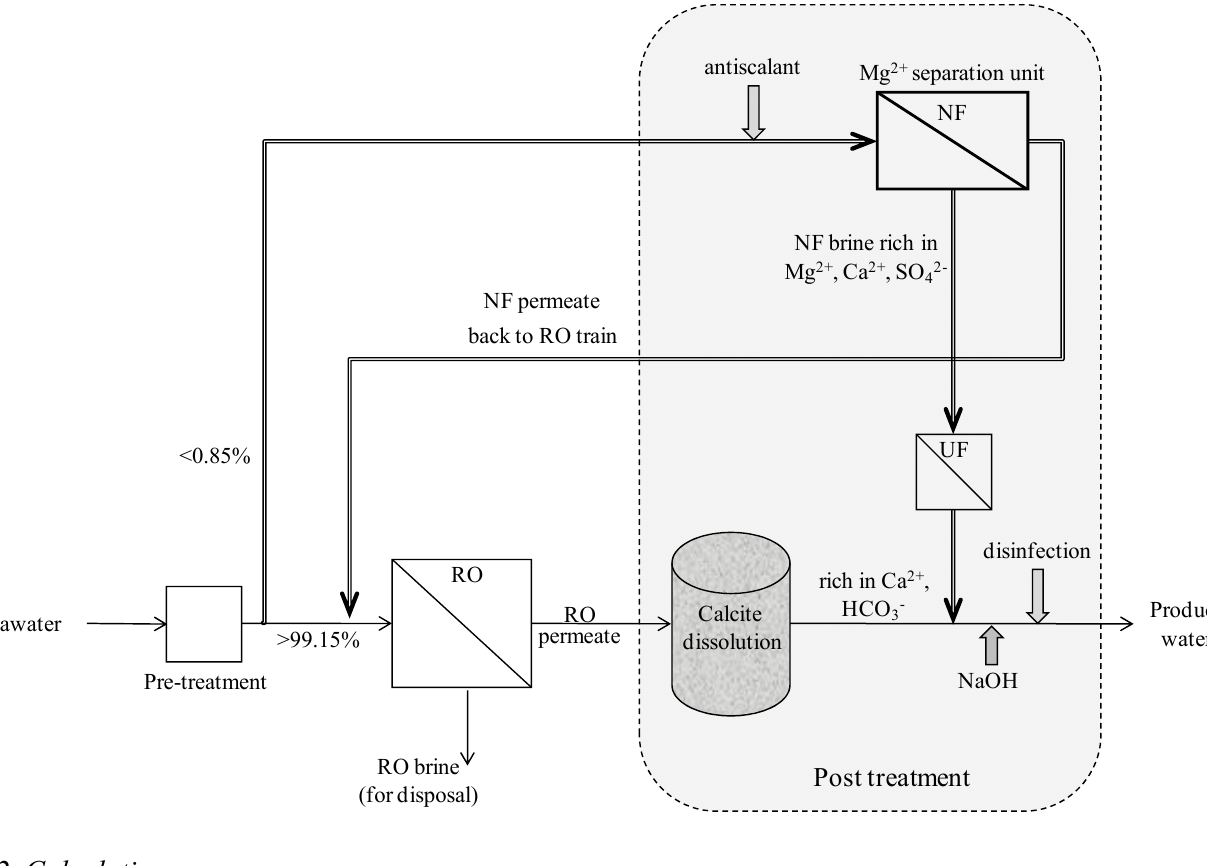
Figure 1. Schematic representation of the Mg(II) enrichment process, based on seawater nanofiltration (NF)